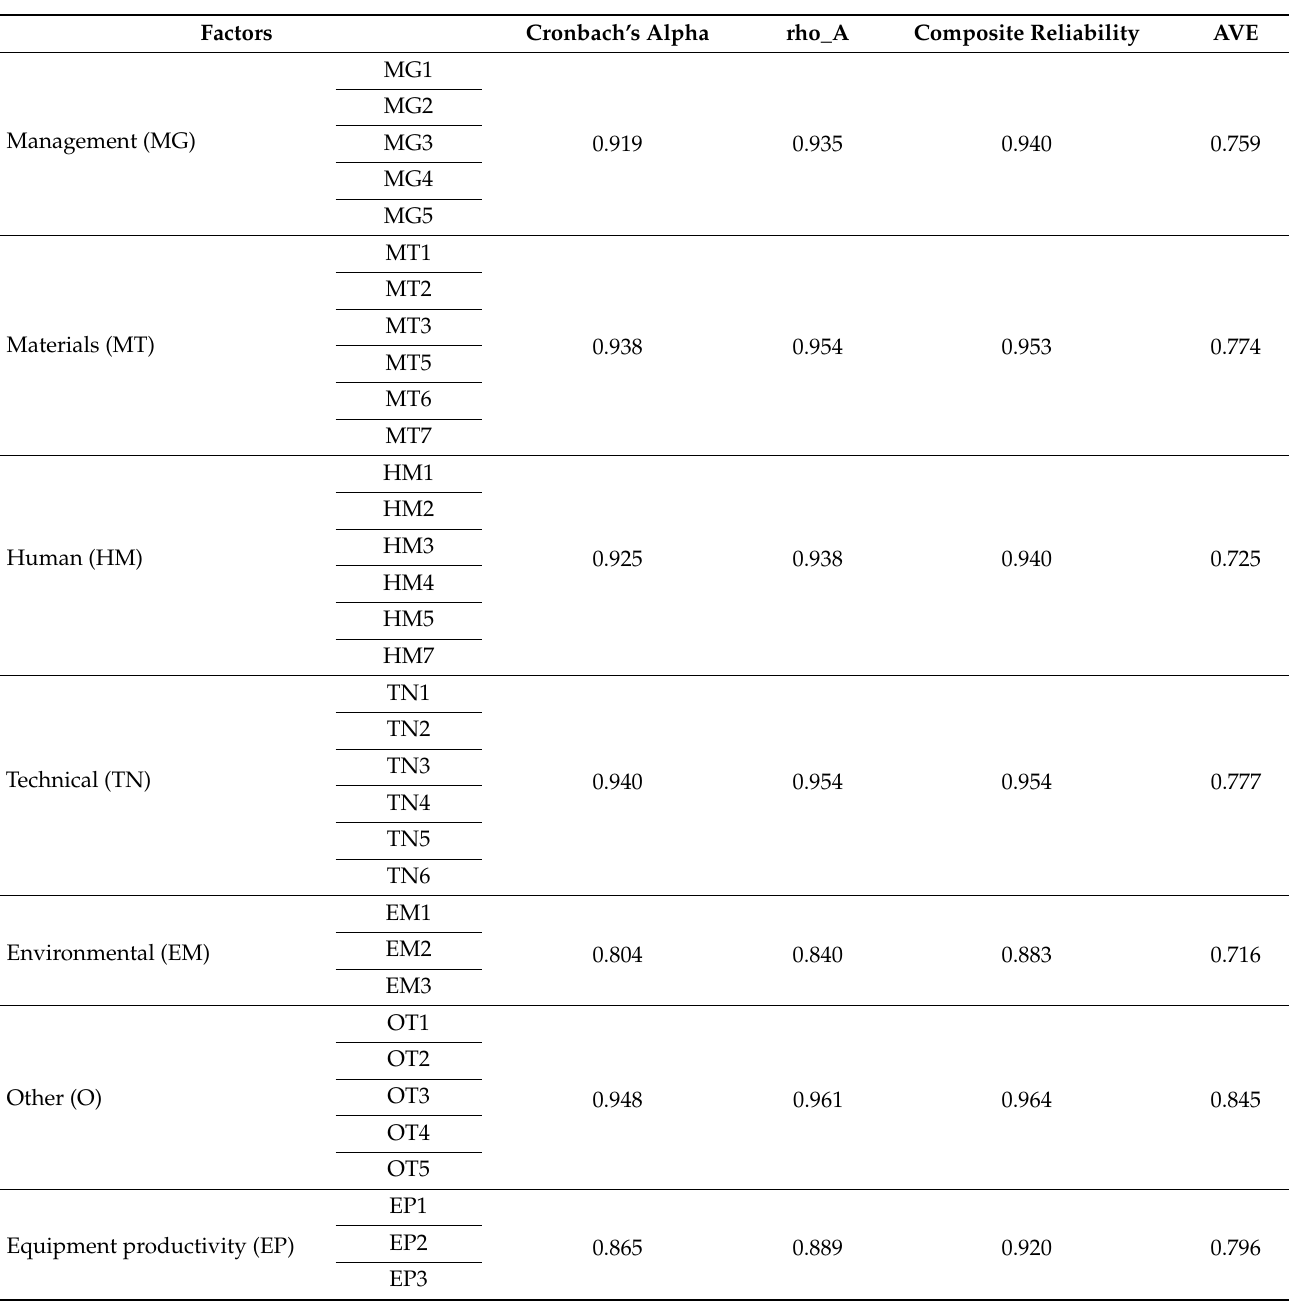
Table 4. Data reliability and